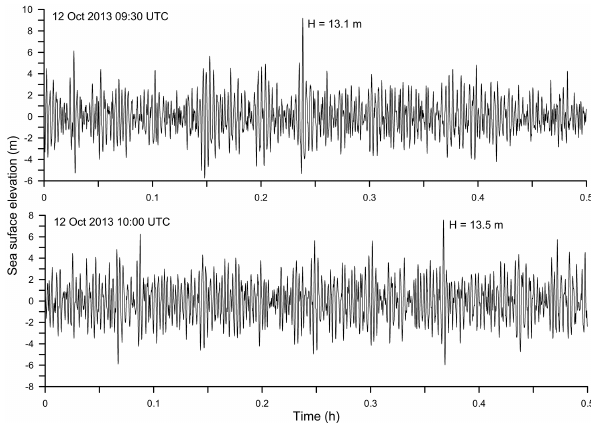
Figure 4. The time series plot of the sea surface elevation recorded at 09:30 and 10:00UTC on 12 October 2013. The maximum wave height recorded was 13.1m and 13.5m and during this period, the buoy was at 50m water